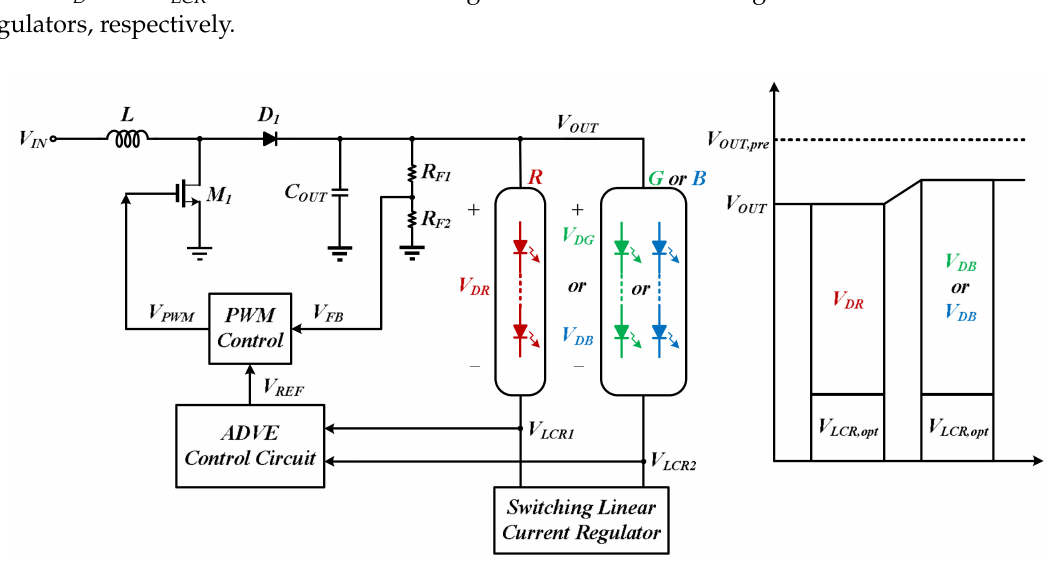
Figure 6. Proposed LED driver with adaptive driving voltage and energy-saving (ADVE)